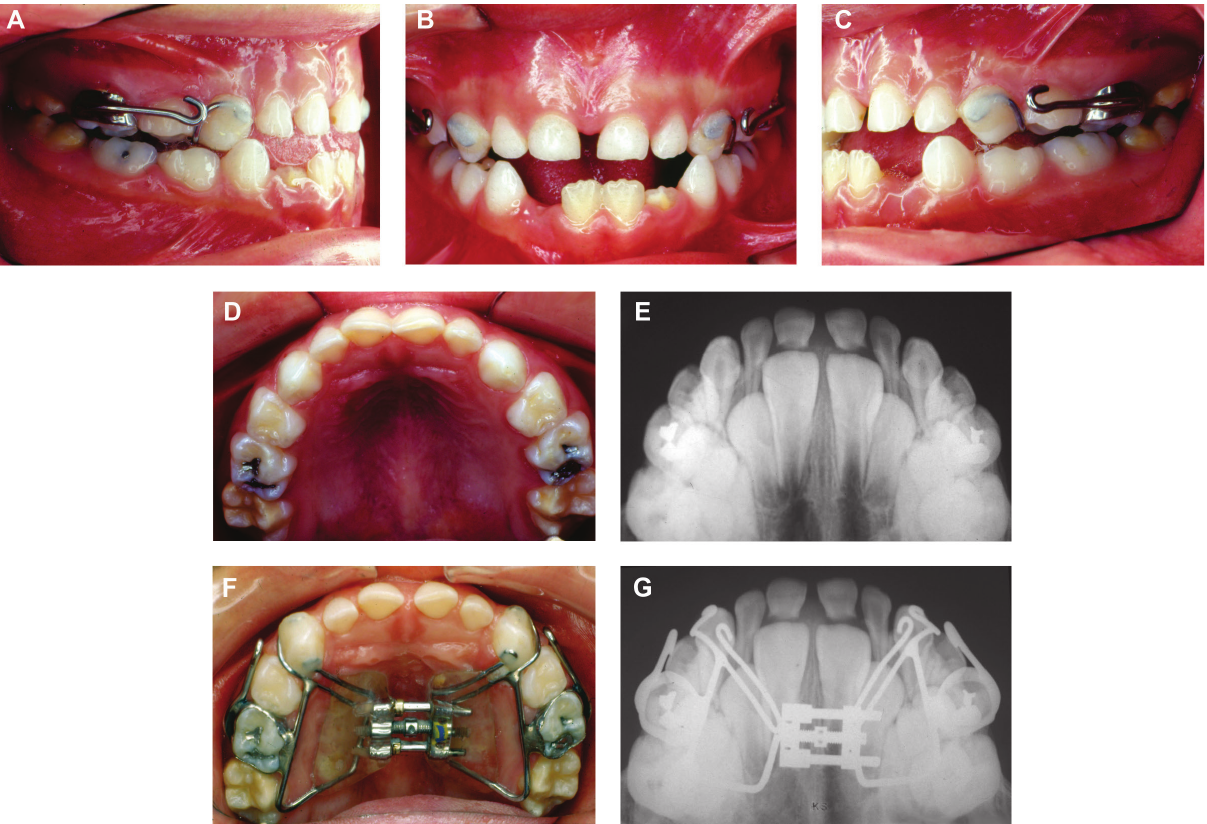
Figure 2- Intraoral photograph before (A, B, C, D and E) and after expansion (F and